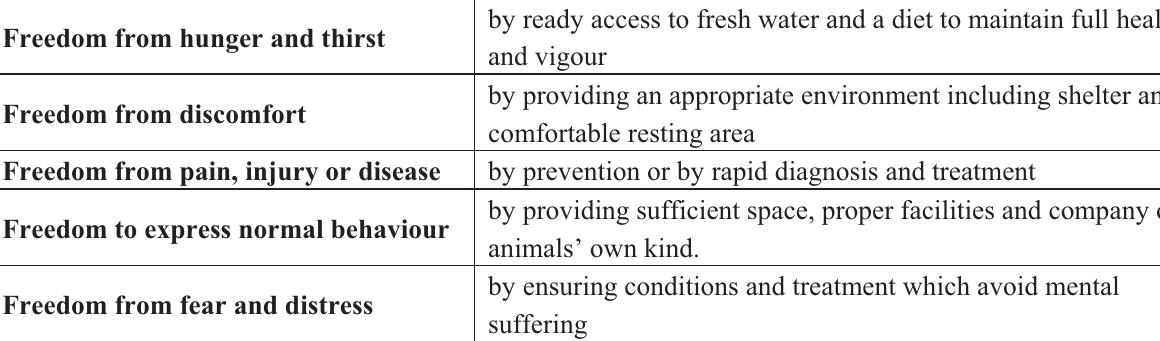
Table 1. The Farm Animal Welfare Council’s Five Freedoms (FAWC, 1993